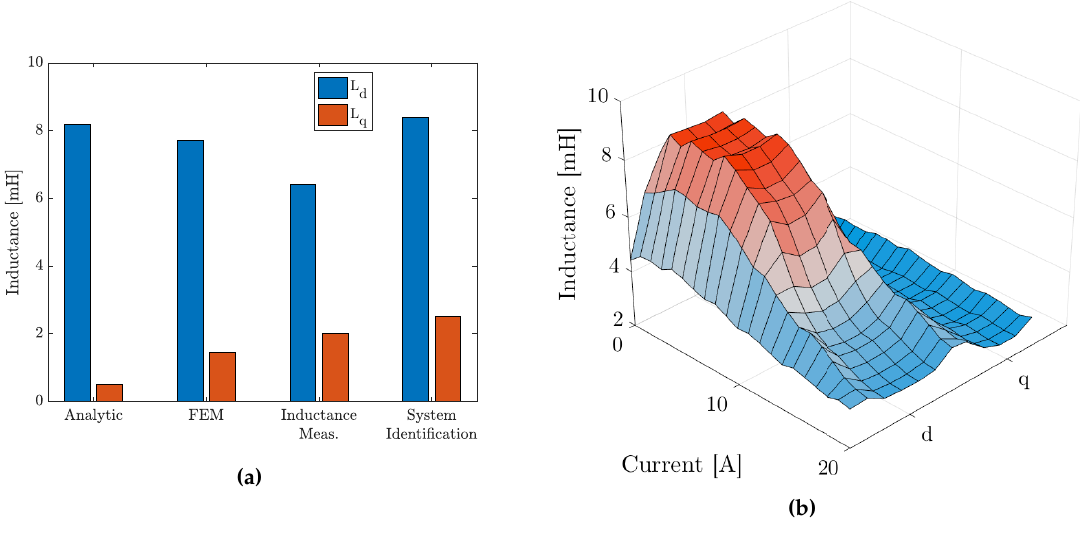
Figure 8. In ( a ), the L d , L q as retrieved from five different methods are presented: analytical, 3D FEM with linear steel, 3D FEM with nonlinear steel, inductance meter, inductance estimation from v and i . A relatively low magnetization was used for the nonlinear FEM computation ( I = 5 A), and the difference from the linear FEM value depends on local saturation points. In ( b ), a map of L ( θ , I ) is